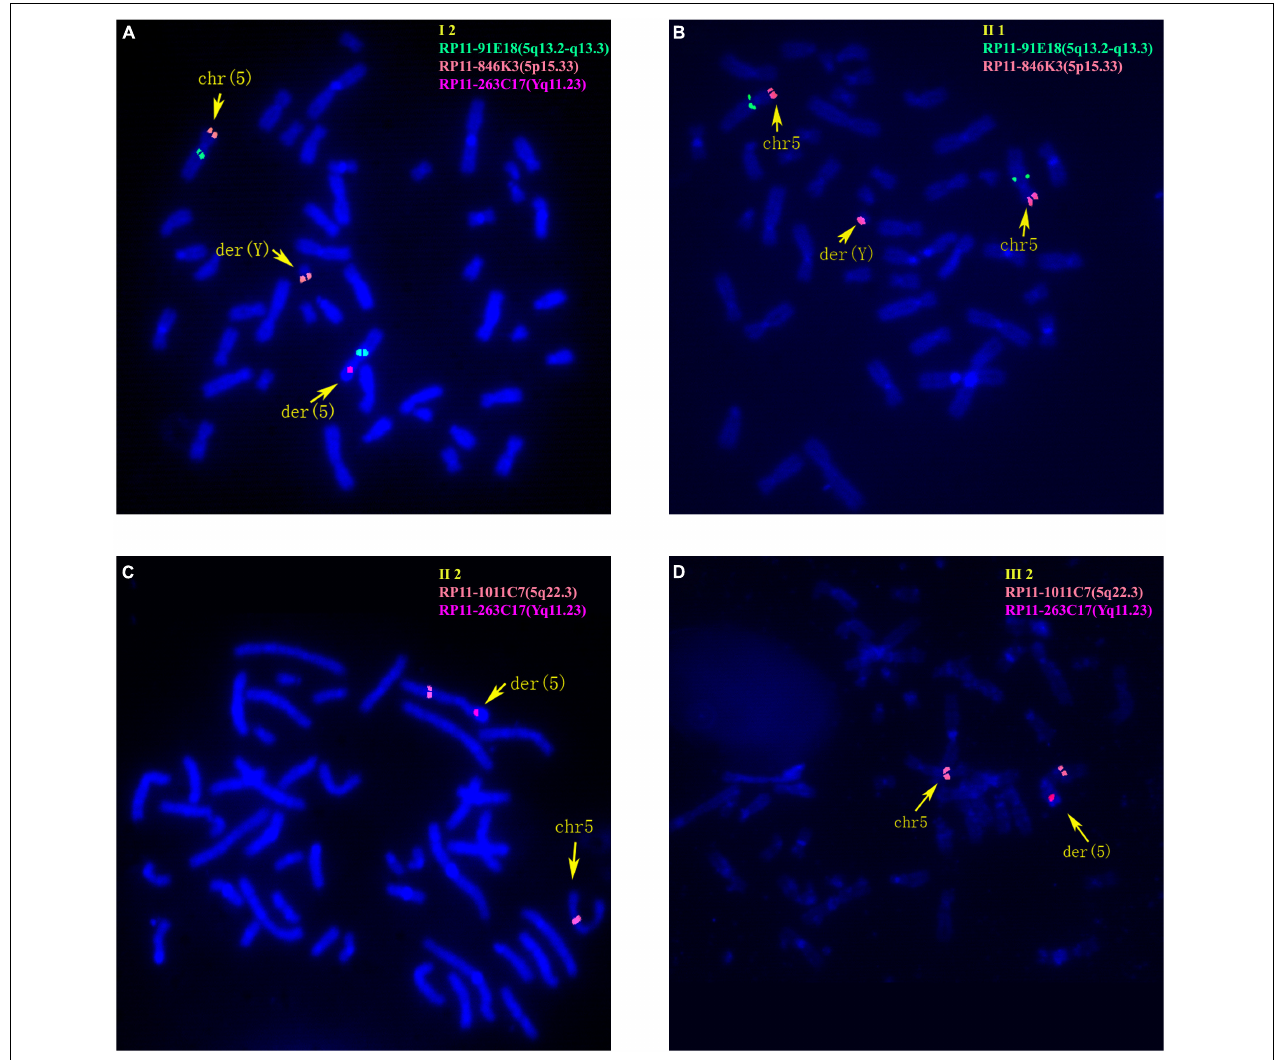
FIGURE 3 | Fluorescence in situ hybridization (FISH) results of family 2. (A) FISH result of metaphase cells from I-2 with BAC probes of RP11-91E18 showing signals mapped to 5q13.2-q13.3 (green), RP11-846K3 showing signals mapped to 5p15.33 (orange) and RP11-263C17 showing signals mapped to Yq11.23 (red). (B) FISH result of metaphase cells from II-1 with RP11-91E18 that are mapped to 5q13.2-q13.3 (green) and RP11-846K3 that are mapped to 5p15.33 (orange). (C) FISH result of metaphase cells from II-2 with BAC probes of RP11-1011C7 showing signals mapped to 5q22.3 (orange) and RP11-263C17 mapped to Yq11.23 (red). (D) FISH result of metaphase cells from III-2 with RP11-1011C7 showing signals mapped to 5q22.3 (orange) and RP11-263C17 mapped to Yq11.23